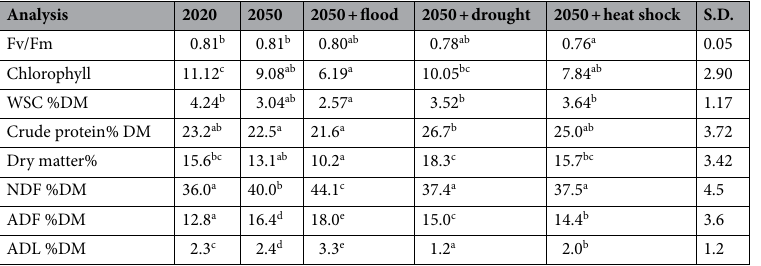
Table 3. Mean values for dry matter% (DM) crude protein (as a % of DM), water soluble carbohydrate (WSC as a % of DM), chlorophyll content, Fv/Fm ratio NDF, ADF and ADL in each climate scenario. Lower case letters indicate significant difference based on ls means with Tukey adjustment ( P < 0.05).